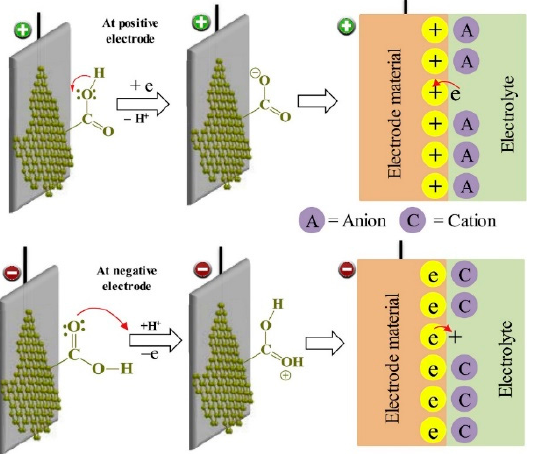
Scheme 17. Proposed mechanism for the reversible pseudo-capacitive reactions of edge functional- ized graphene. Reproduced with permission from [46], copyright 2018 Elsevier. ized graphene. Reproduced with permission from [46], copyright 2018